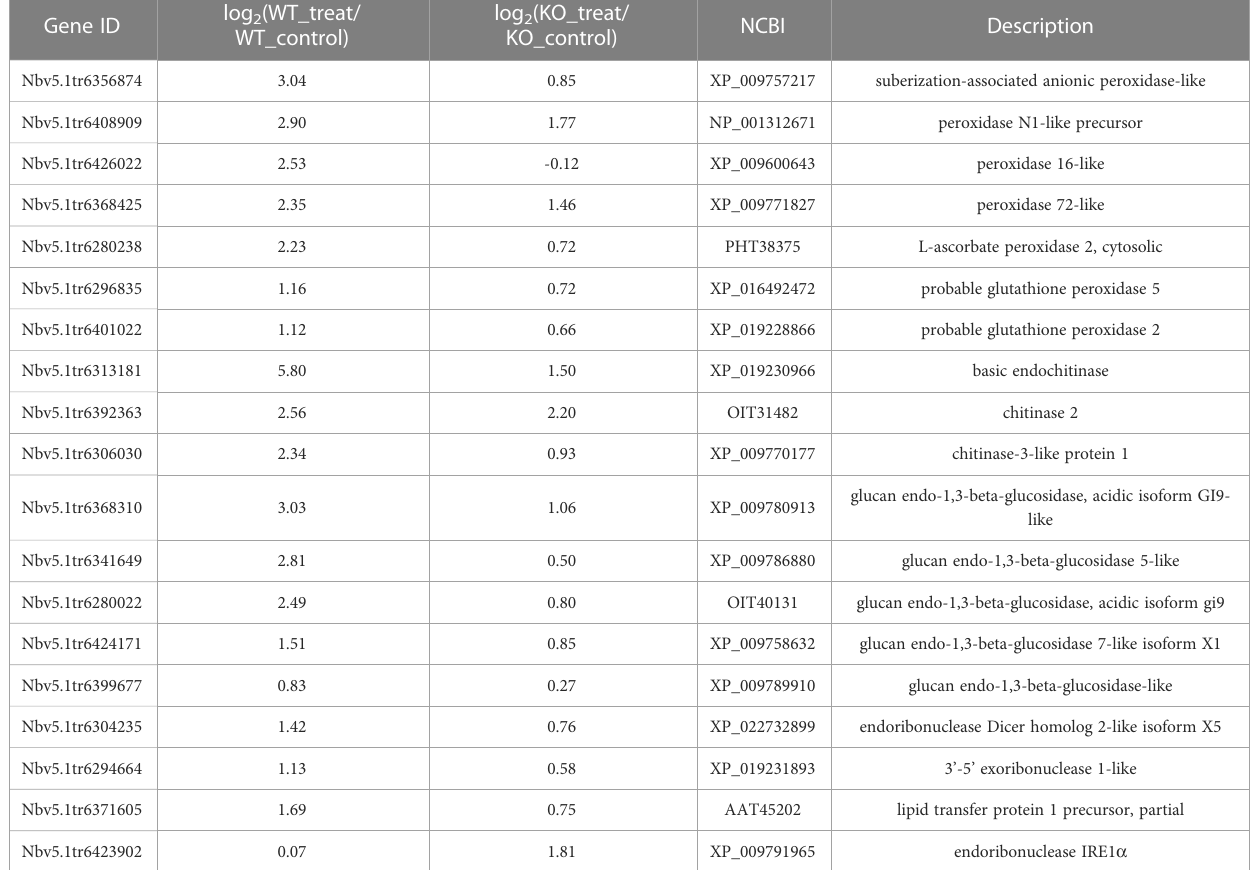
TABLE 1 RNAs encoding proteins that interfere with the induction of autophagy, and the IRE1 RNA.